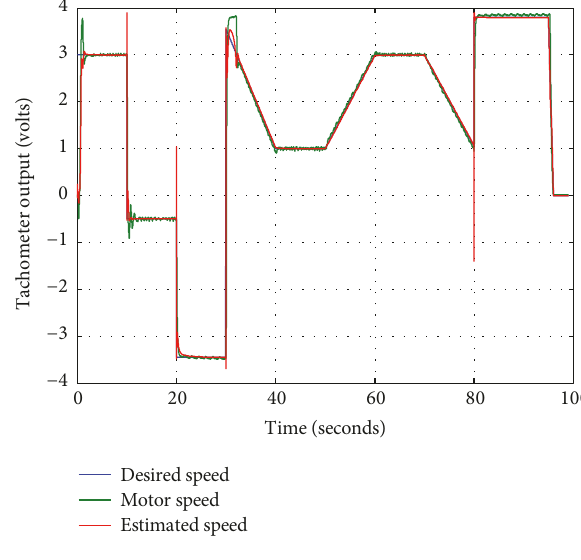
Figure 19: Speed control of DC motor.